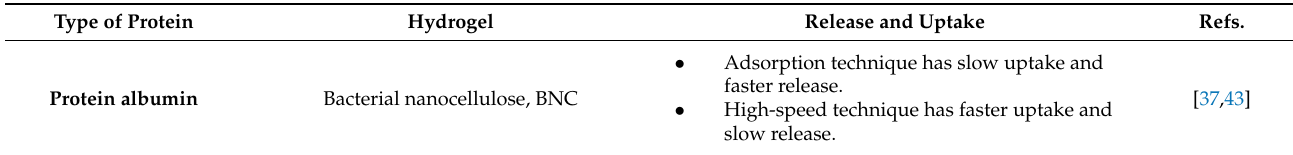
Table 1. Review on the use of protein albumin with biomaterial-based hydrogel. Type of